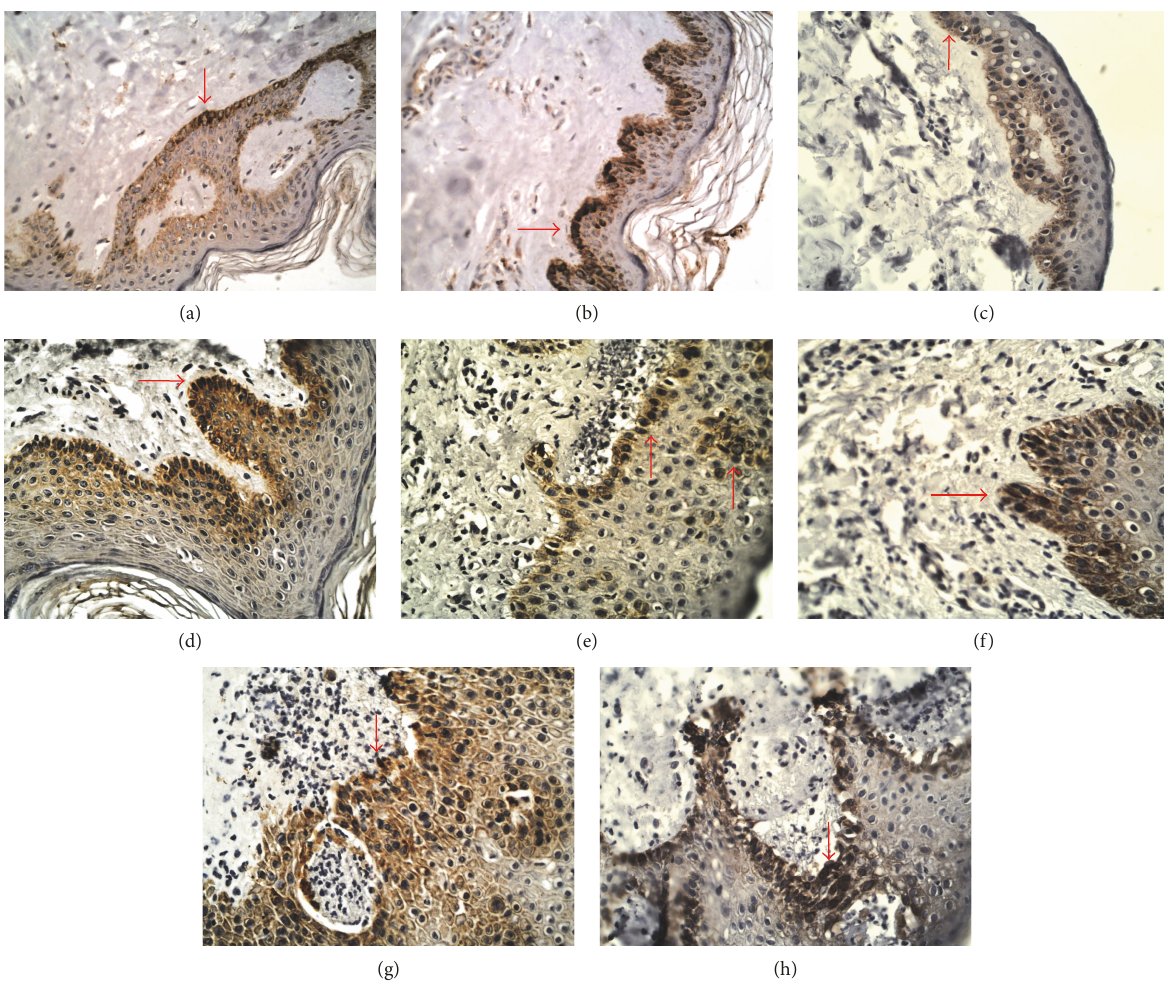
Figure 3: Immunoexpression of JAK/STAT proteins in epidermis, DH, 400x, immunohistochemistry. Immunoexpression of JAK3 in epidermis (a) perilesional skin 14.38 ± 3.61 and (e) skin lesions 18.89 ± 4.67, p > 0 05 ; immunoexpression of STAT2 in epidermis (b) perilesional skin 15.79 ± 2.06 and (f) skin lesions 17.15 ± 2.81. NS; immunoexpression of STAT4 in epidermis (c) perilesional skin 24.10 ± 3.40 and (g) skin lesions 29.08 ± 4.38, p < 0 05 ; immunoexpression of STAT6 in epidermis (d) perilesional skin 18.21 ± 3.49 and (h) skin lesions 27.85 ± 4.68, p < 0 05